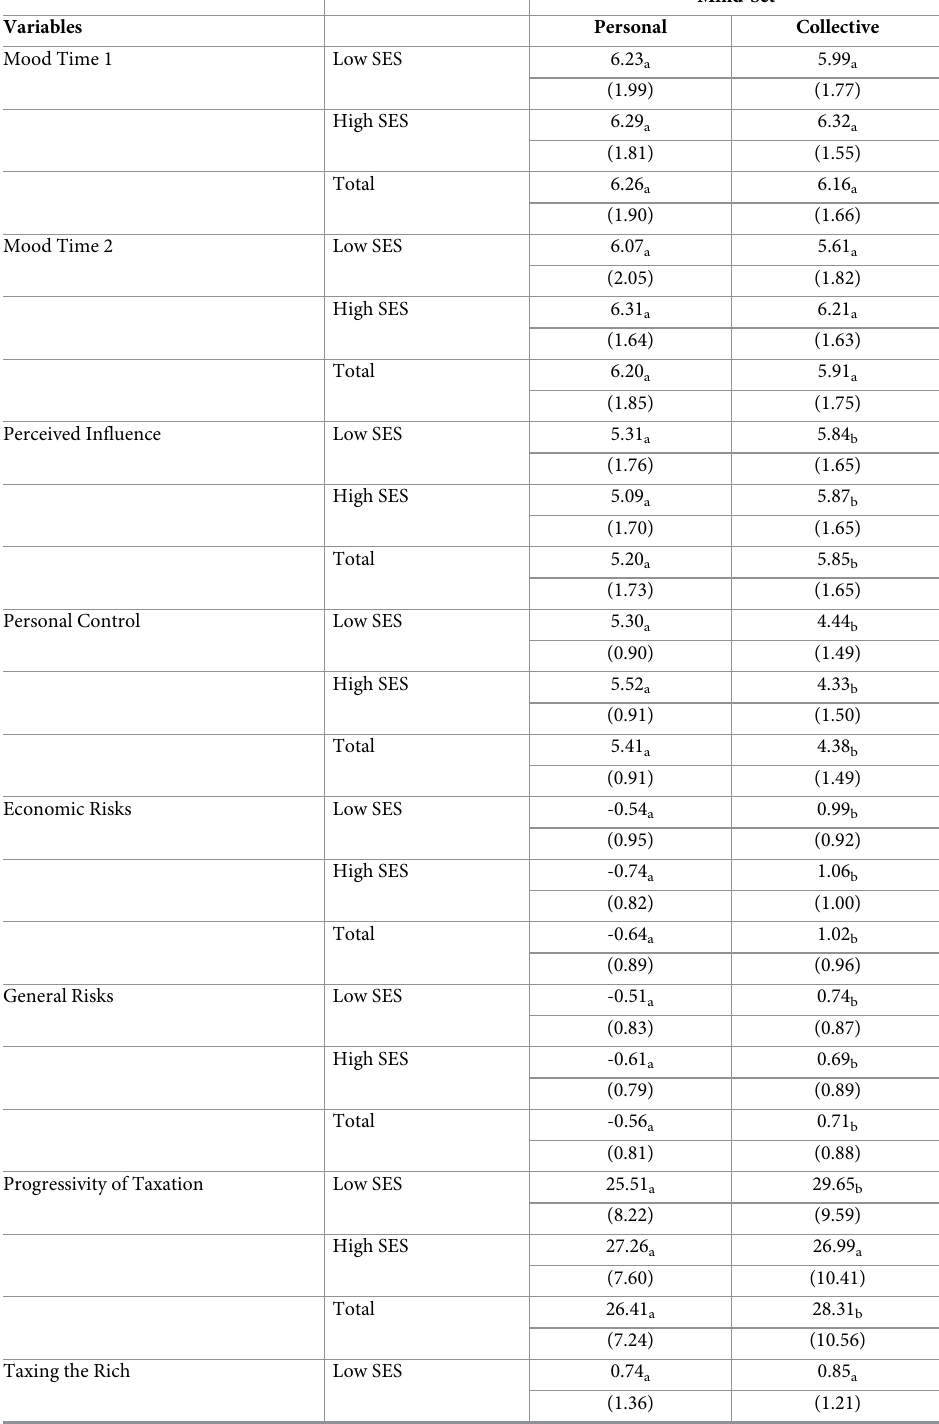
Table 4. Study 2 ( N = 384). Means and standard deviations of Mood Time 1, Mood Time 2, Perceived Influence, Per- sonal Control, Economic Risks, General Risks, Progressivity of Taxation, and Taxing the Rich as a function of